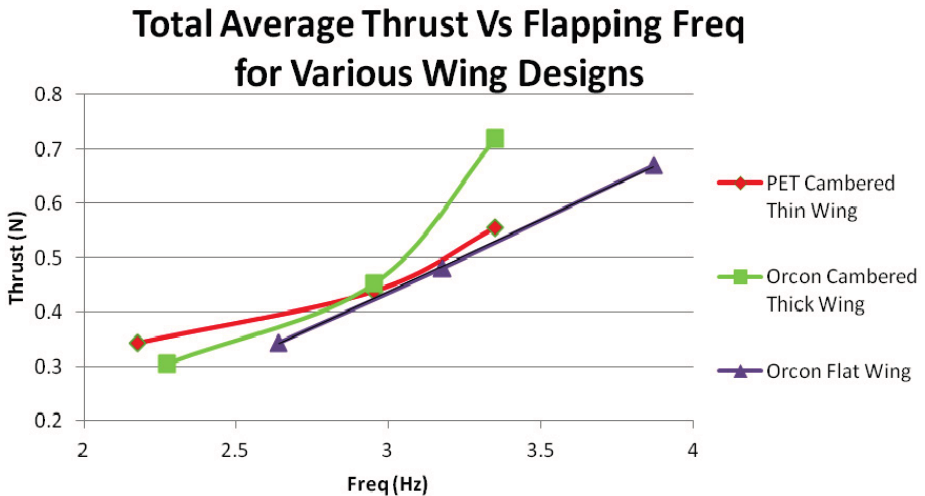
Figure 34. Total average thrust against flapping frequency for various